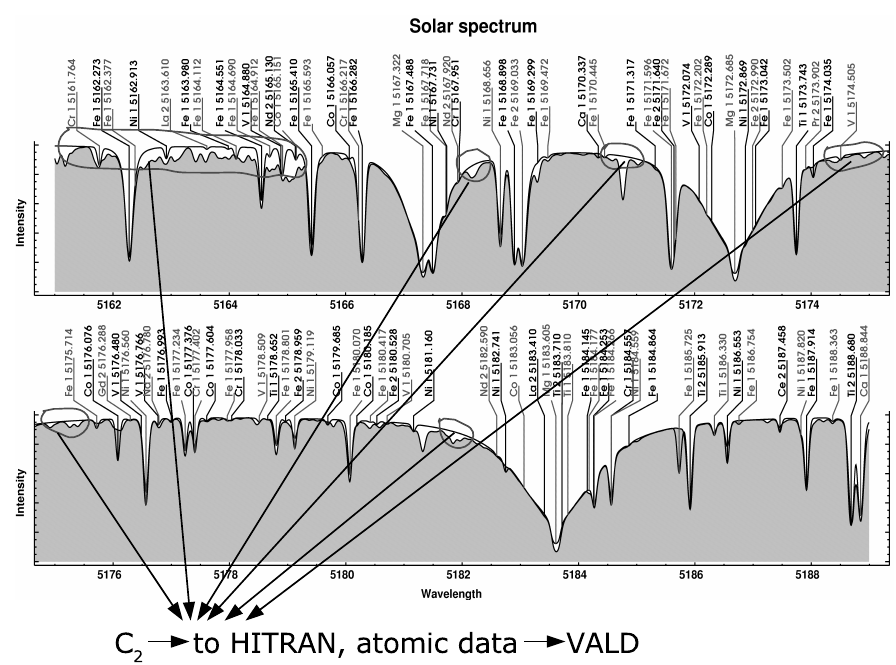
Fig. 2. The observed solar spectrum in the region of the 5167{83 (cid:23)A Mg I triplet (shadowed area). Synthetic spectrum calculations with atomic lines only are shown by full line. Spectral regions with molecular C 2 lines are indicated by contour